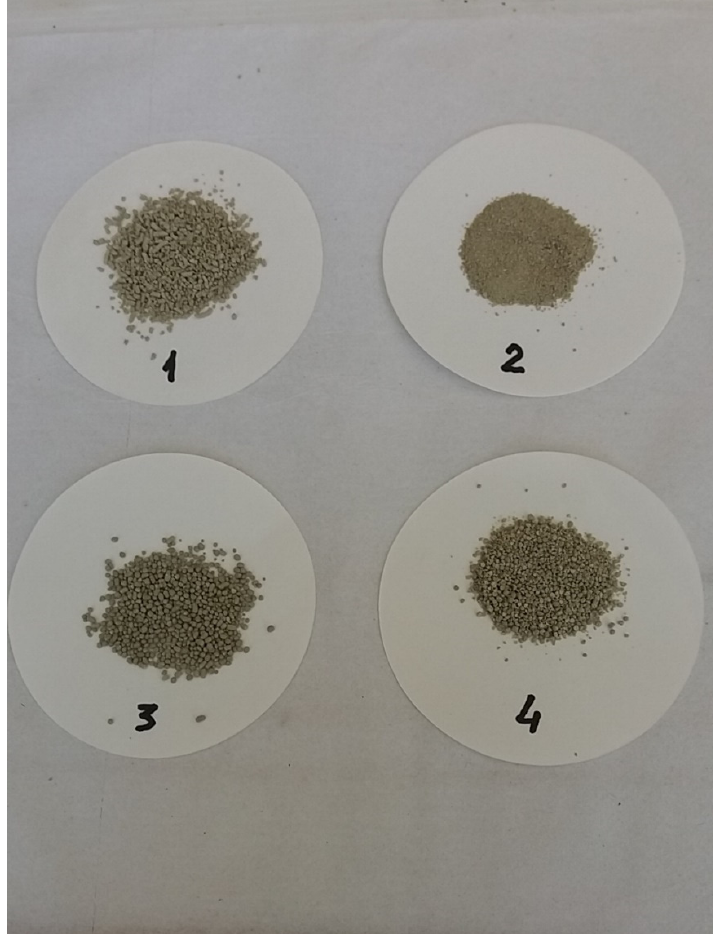
Figure 2. Effect of heating on morphology of micelle–clay granules. 1. Non-spherical granules—drying for 90 min in an ordinary oven. 2. Non-spherical granules—drying for 4 min in a MW oven. 3. Spherical granules—drying for 90 min in an ordinary oven. 4. Spherical granules—drying for 4 min in a MW oven.